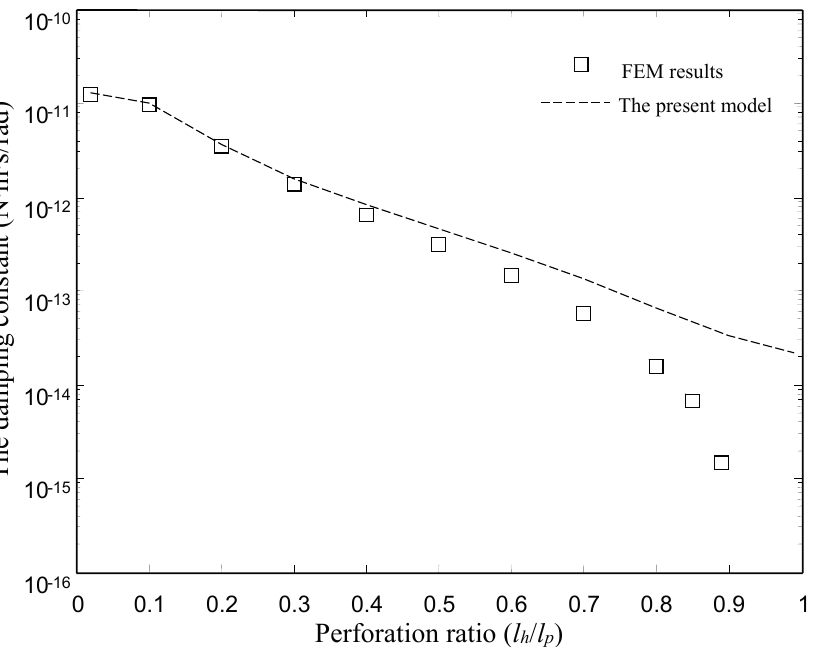
Figure 11. Comparison of the damping constant of the type II devices obtained by the FEM model and the present model.